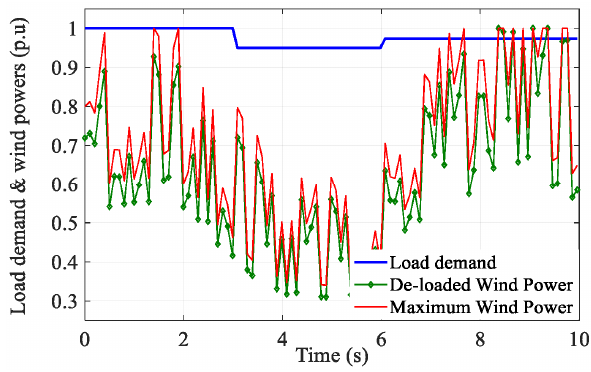
Figure 16. Load-demand and WT powers.